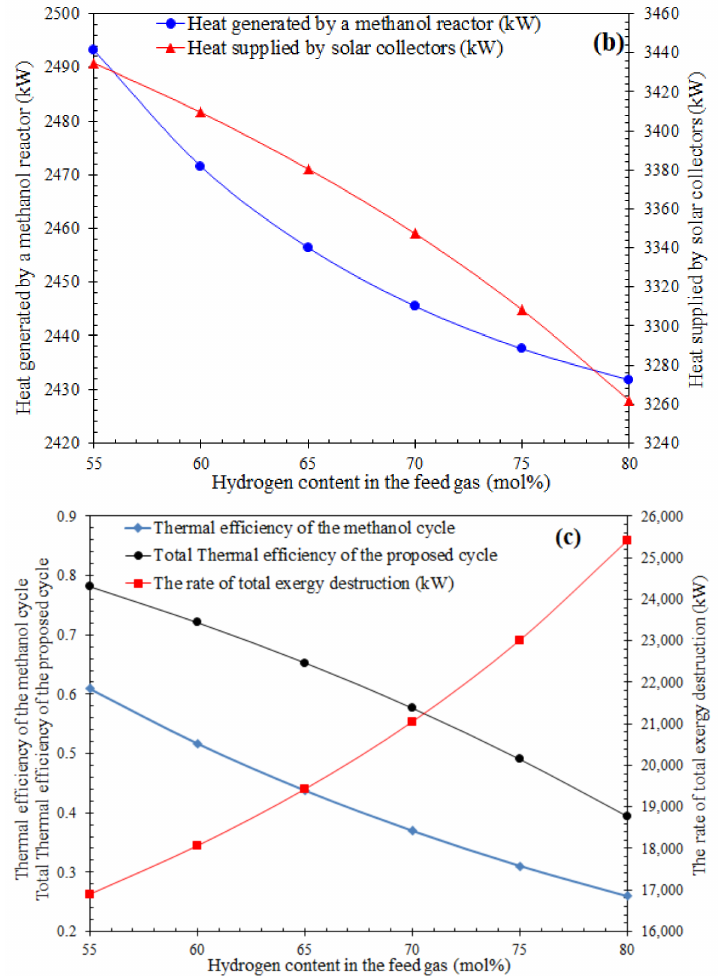
Figure 11. The influence of the changes of the hydrogen content of crude feed gas on main outcome parameters: ( a ) The influence of the changes of the hydrogen content of crude feed gas on the methanol production rate and total exergy efficiency; ( b ) The influence of the changes of the hydrogen content of crude feed gas on heat generated by the methanol production reactor and heat supplied by solar collectors; ( c ) The influence of the changes of the hydrogen content of crude feed gas on total thermal efficiency and thermal efficiency of the methanol production cycle—total exergy